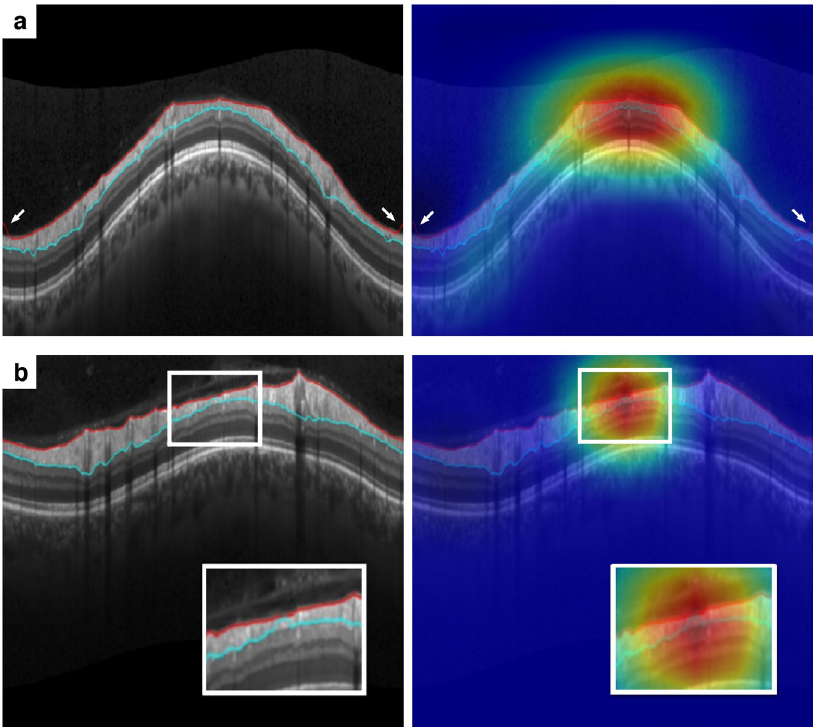
Figure 3. Spectral-domain optical coherence tomography (SDOCT) B-scans with disagreement about the presence of segmentation errors between human graders and the deep learning algorithm. ( a ) Small segmentation error in the internal limiting membrane occurring at the borders of the image (arrows) missed by the deep learning algorithm. The probability of segmentation error given by the deep learning algorithm was 15%. ( b ) Small segmentation error (detail) missed by the human labelling but identified by the deep learning algorithm. The probability of segmentation error given by the deep learning algorithm was